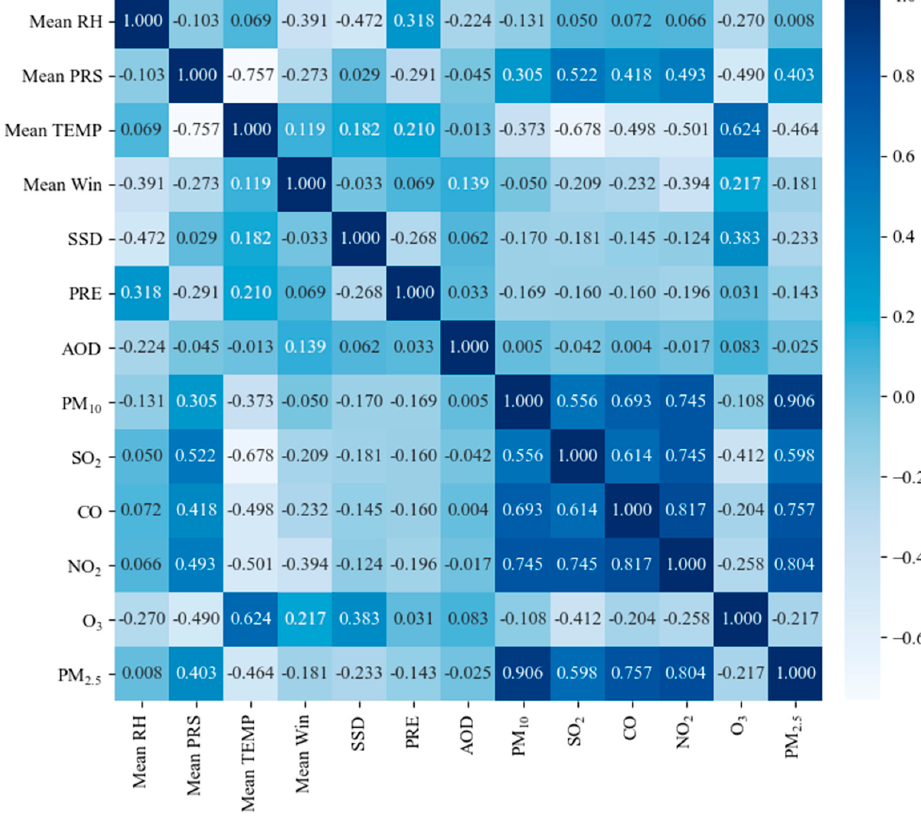
Figure 5. Heatmap of correlations between the variables. Among the major atmospheric pollutants, the O 3 concentration was negatively but weakly correlated ( − 0.217) with PM 2.5 . The main reason is that an increase in the PM 2.5 concentration can increase the scattering of solar radiation in the visible and near ‐ infrared bands, thus reducing the photochemical rate and, finally, leading to a decrease in the O 3 concentration. However, SSD and temperature had a more obvious impact on the total solar radiation energy; consequently, O 3 had a stronger correlation with the mean TEMP and SSD, with correlation coefficients reaching 0.624 and 0.383, respectively. Significant positive correlations were observed between other pollutants and PM 2.5 , with coefficients ranging from 0.906 to 0.598 in the order of PM 10 (cid:3408) NO 2 (cid:3408) CO (cid:3408) SO 2 . In fact, PM 10 , NO 2 , CO, and SO 2 concentrations were positively correlated, indicating that the emission sources of these pollutants were similar; for example, they may have been the burning of straw and coal [34]. In addition, the photochemical reactions of NO 2 , CO, and SO 2 can generate nitrate and carbonate, which can lead to an increase in PM 2.5 [35]. Among the meteorological factors, the mean PRS was positively correlated with the PM 2.5 concentration, while the mean TEMP, mean WIN, SSD, and PRE were negatively correlated with the PM 2.5 concentration. This is because when pollution occurs in a season with low temperatures, such as winter, high pressure and low wind speed promote a sta ‐ ble state for the near ‐ surface atmosphere, which increases the strength of the thermal in ‐ version layer and hinders the diffusion of pollutants [36]. A larger SSD can enhance the photolysis of organic carbon, which is a major component of particulate matter, thereby reducing the PM 2.5 concentration [37]. A higher wind speed has a diffusion and dilution effect on PM 2.5 , reducing its concentration. More precipitation corresponds to a more sig ‐ nificant removal of moisture, which is also an important reason for the reduction in the PM 2.5 concentration [38,39]. The correlation coefficients between the mean RH and AOD